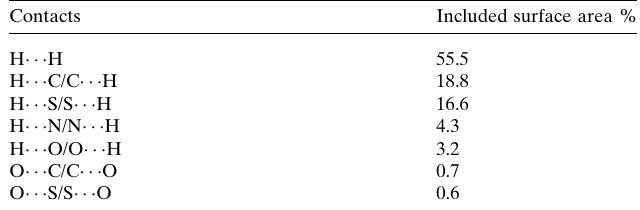
Table 2 Percentage contributions to the Hirshfeld surface for 1 .